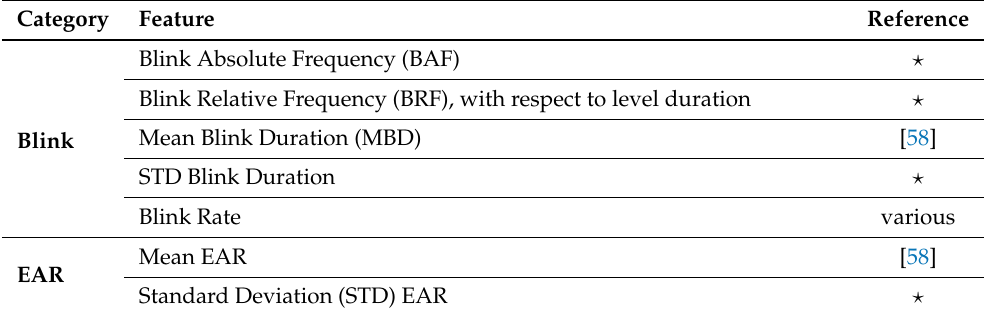
Table 5. Employed blink and EAR features, along with proper reference. (cid:63) : first presented/employed in this